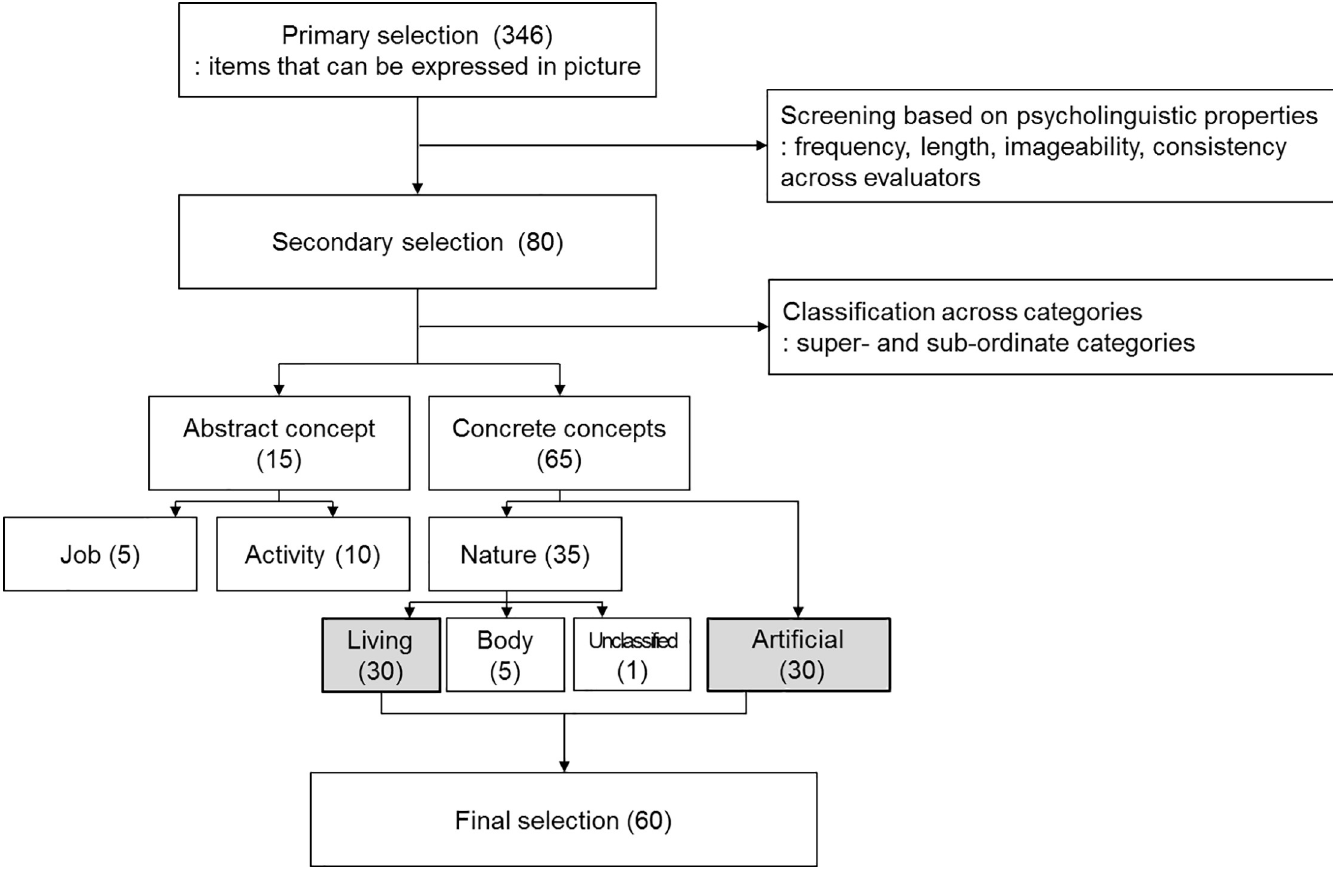
Fig 2. Process of item selection for the